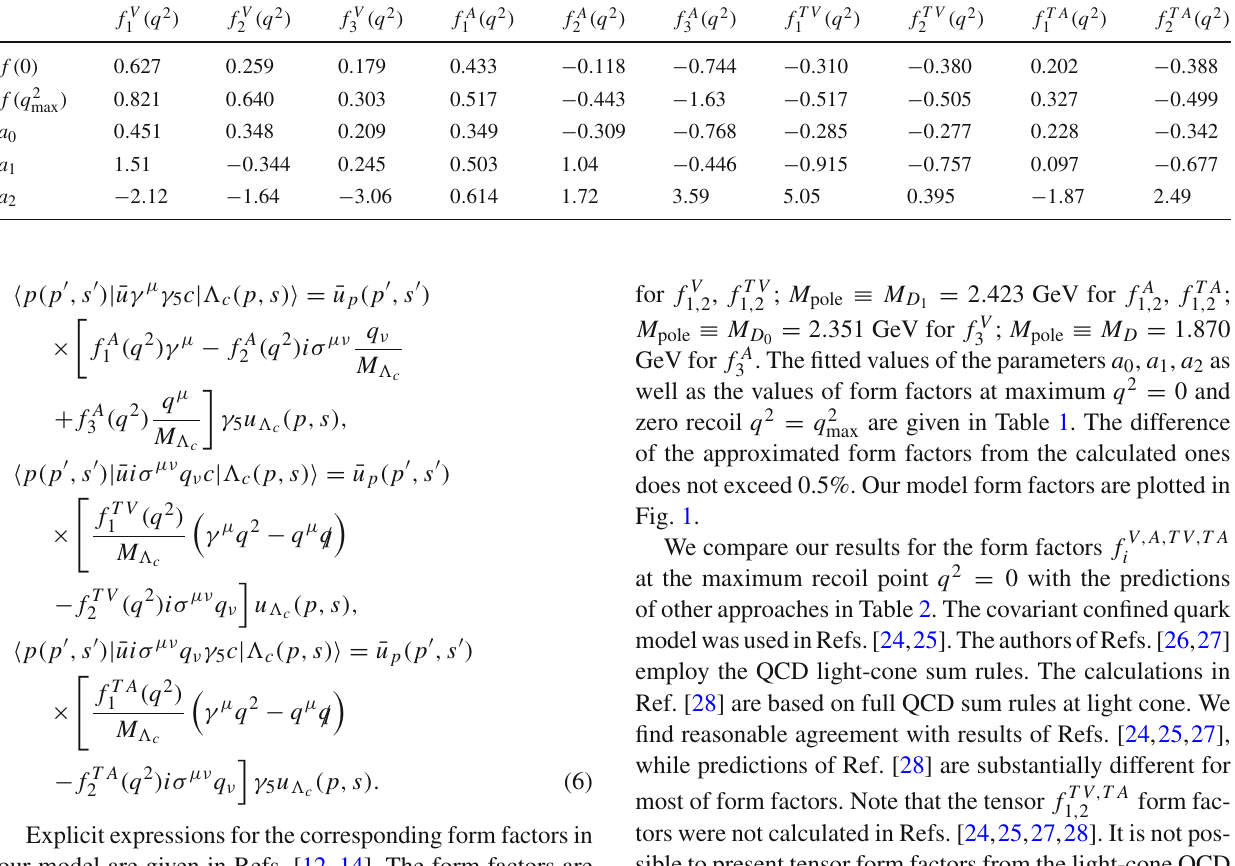
Table 1 Form factors of the weak (cid:2) c → p transition